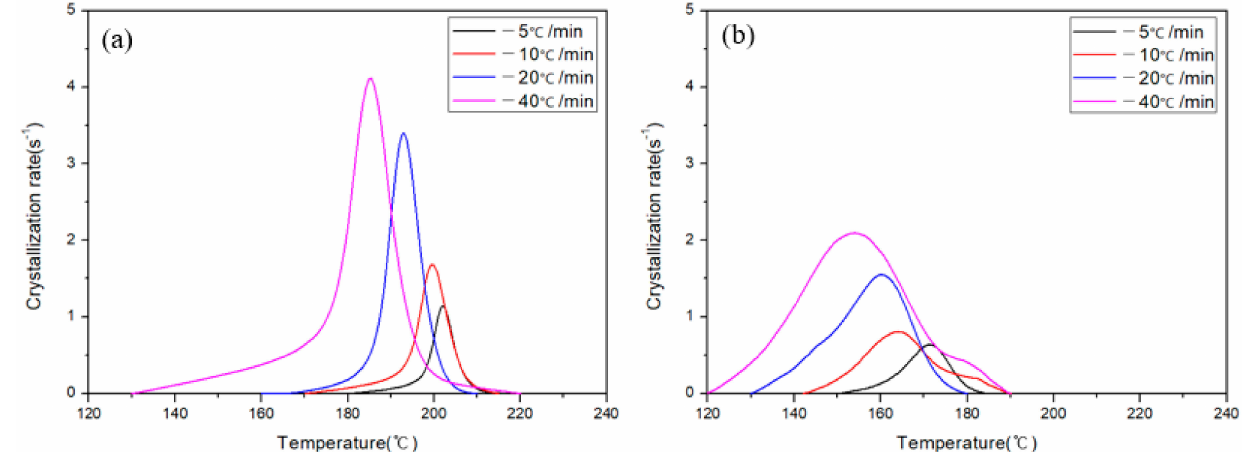
Figure 7. Crystallization rate of ( a ) APA and ( b ) Carbon/APA composite at different cooling